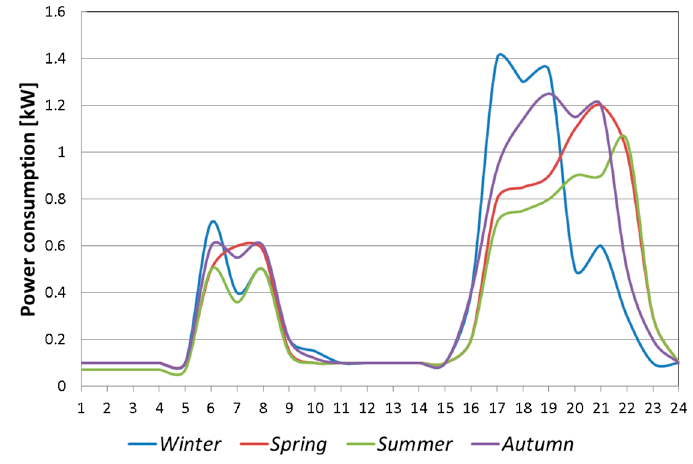
Figure 1. Average power consumption profile of one day.